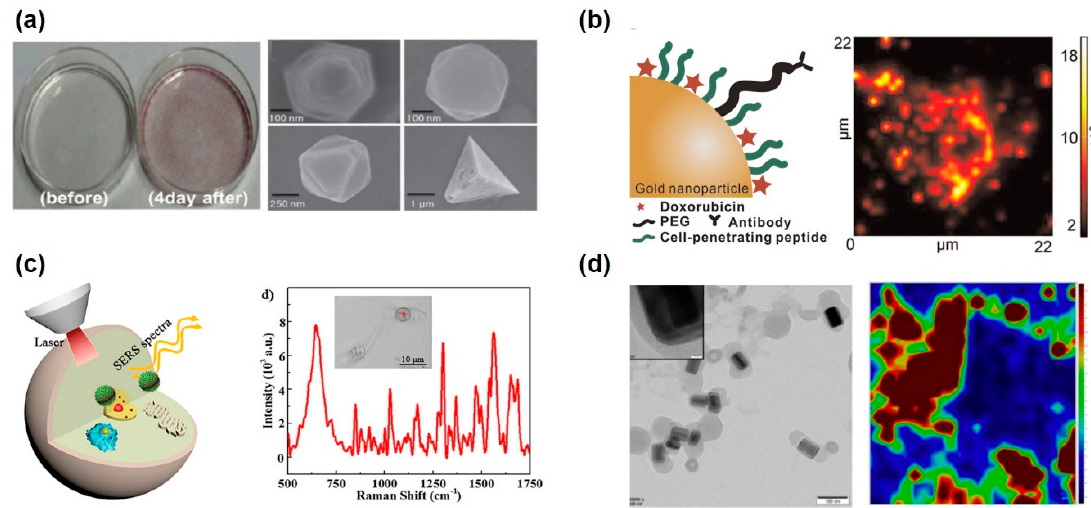
Figure 3. SERS-based intracellular analysis using metallic nanoparticles. ( a ) Synthesis of Au Figure3. SERS-basedintracellularanalysisusingmetallicnanoparticles. ( a nanoparticle in the HeLa cells after incubation with a gold chloride solution and they were measured